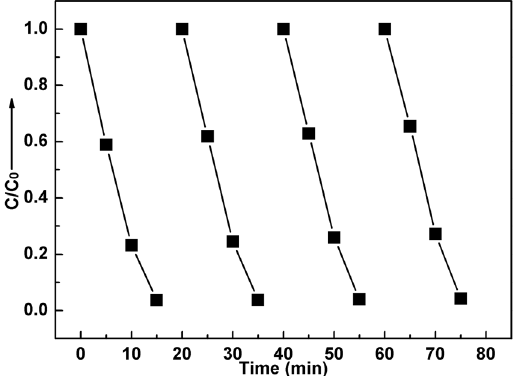
Figure 7. Cycle photodegradation runs of MB solution over Eu-doped calcium aluminate sample.